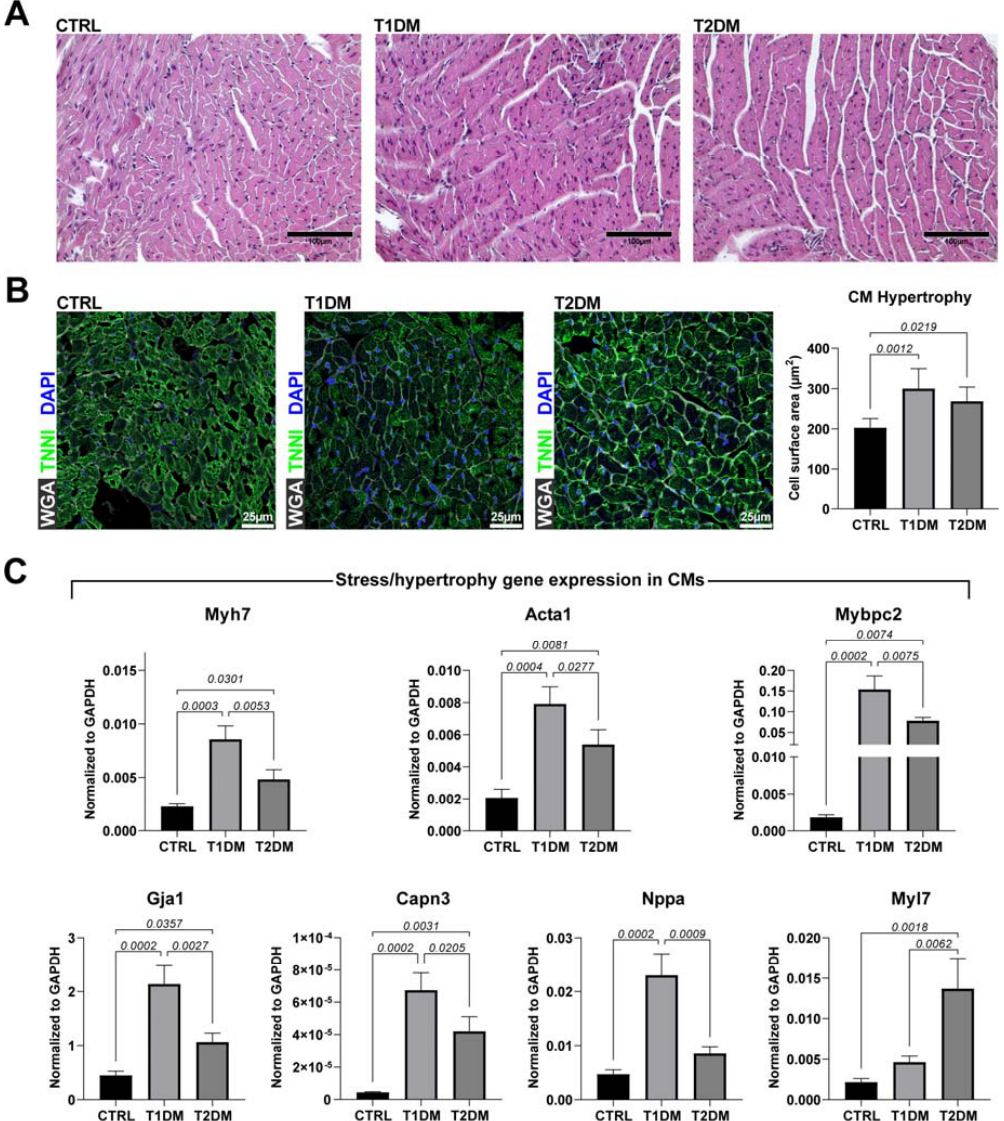
Figure 2. STZ-based T1DM and T2DM mouse models displayed pathological left ventricular re- modeling accompanied by stress-induced gene expression and hypertrophy. ( A ) Representative cross-section images of cardiac tissues, from CTRL, T1DM and T2DM mice, stained with hematoxylin and eosin. Scale bar = 100 µ m. (CTRL, n = 7; T1DM, n = 8; T2DM, n = 9.) ( B ) Representative confocal images of cardiac cross-sections and bar graph showing cardiomyocyte hypertrophy in T1DM and T2DM mice when compared to CTRL mice (WGA, wheat germ agglutinin, Cy5 staining; cTnI, green; DAPI, blue nuclei). Scale bar = 25 µ m. (CTRL, n = 7; T1DM, n = 8; T2DM, n = 9.) ( C ) Bar graphs showing the expressions of stress/hypertrophy genes in cardiomyocytes isolated from CTRL, T1DM and T2DM mice (n = 3). Data are mean ±